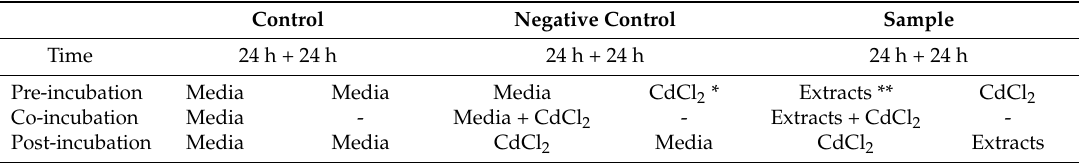
Table 2. The experimental treatment group on anti-cadmium toxicity and DNA protective properties. Control Negative Control Sample Time 24 h + 24